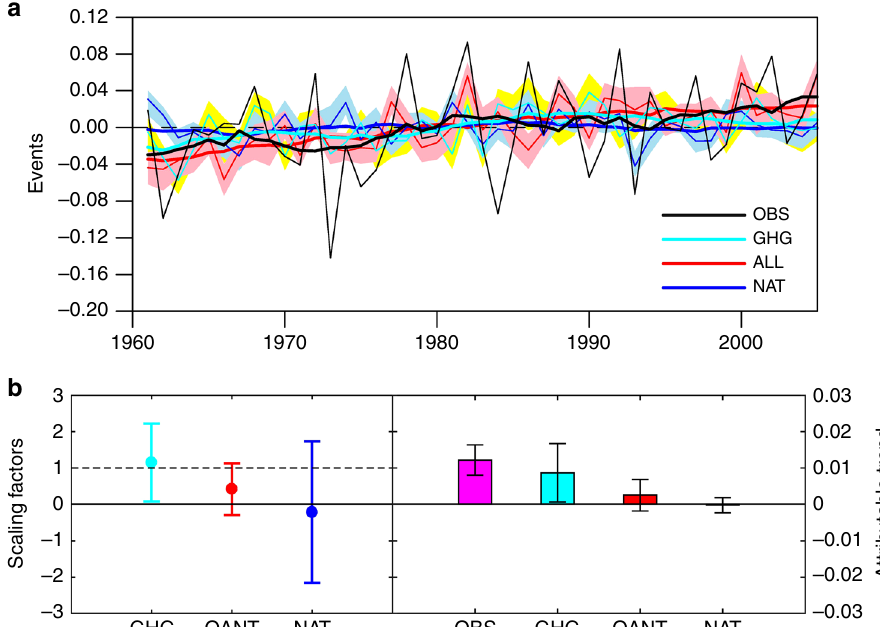
Fig. 4 Attribution for historical change in fl ash drought frequency. a Observed and simulated anomalies of the number of fl ash drought events per year averaged over China. Black line shows the ensemble mean of OBS/CLM4.5, OBS/VIC, and OBS/NoahMP simulations, red, blue, and cyan lines show the land surface model ensemble simulations driven by CMIP5 climate model ensemble simulations with ALL, NAT, and GHG forcings, respectively (see Supplementary Table 1 for details). The thick lines are 10 years running means, and the pink, cyan, and yellow shadings display the 5 – 95% ranges of ALL, NAT, and GHG ensemble simulations respectively. b The best estimates of the scaling factors (left axis) and attributable increasing trends (right axis) from three-signal (GHG, OANT = ALL-GHG-NAT and NAT) analyses of fl ash drought changes for the period 1961 – 2005. Error bars indicate their corresponding 5 – 95% uncertainty ranges estimated via Monte Carlo simulations. All the statistics were calculated during the growing seasons (April – September)